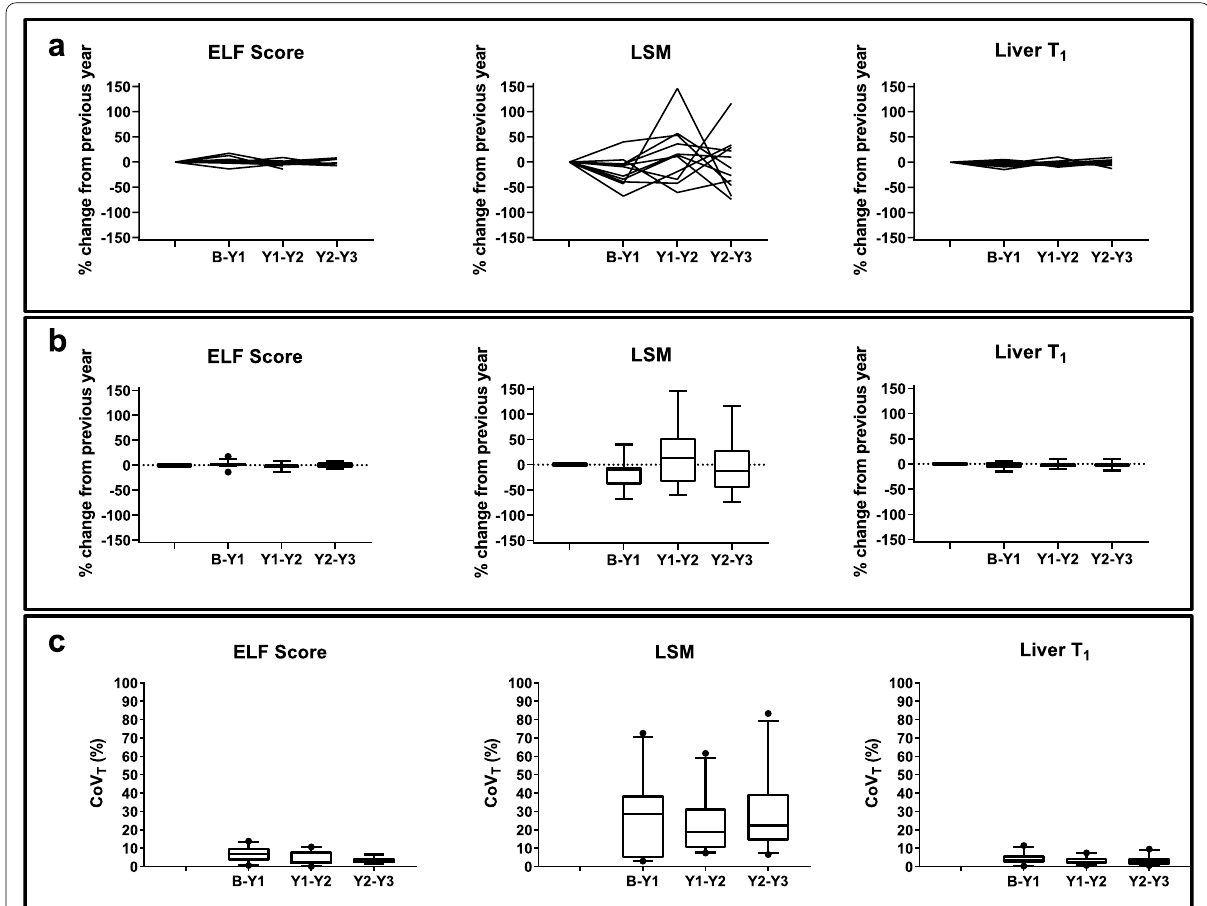
Fig. 6 ELF score, Fibroscan ® LSM and liver T1 for the stable compensated cirrhosis control patients who completed all three annual follow-up scans: a individual subject percentage change from baseline values at year 1, year 2, and year 3; b group percentage change from baseline values at year 1, year 2, and year 3. Bars indicate the interquartile range and bold line shows the median percentage change. There was no significant difference from baseline ( p > 0.05 Bonferroni-corrected); c Year-to-year coefficient of variation (CoV T ) in magnetic resonance imaging measures. Bars indicate the interquartile range and the horizontal bold line shows the median CoV, dots represent outliers. ELF Enhanced liver fibrosis, LSM Liver stiffness